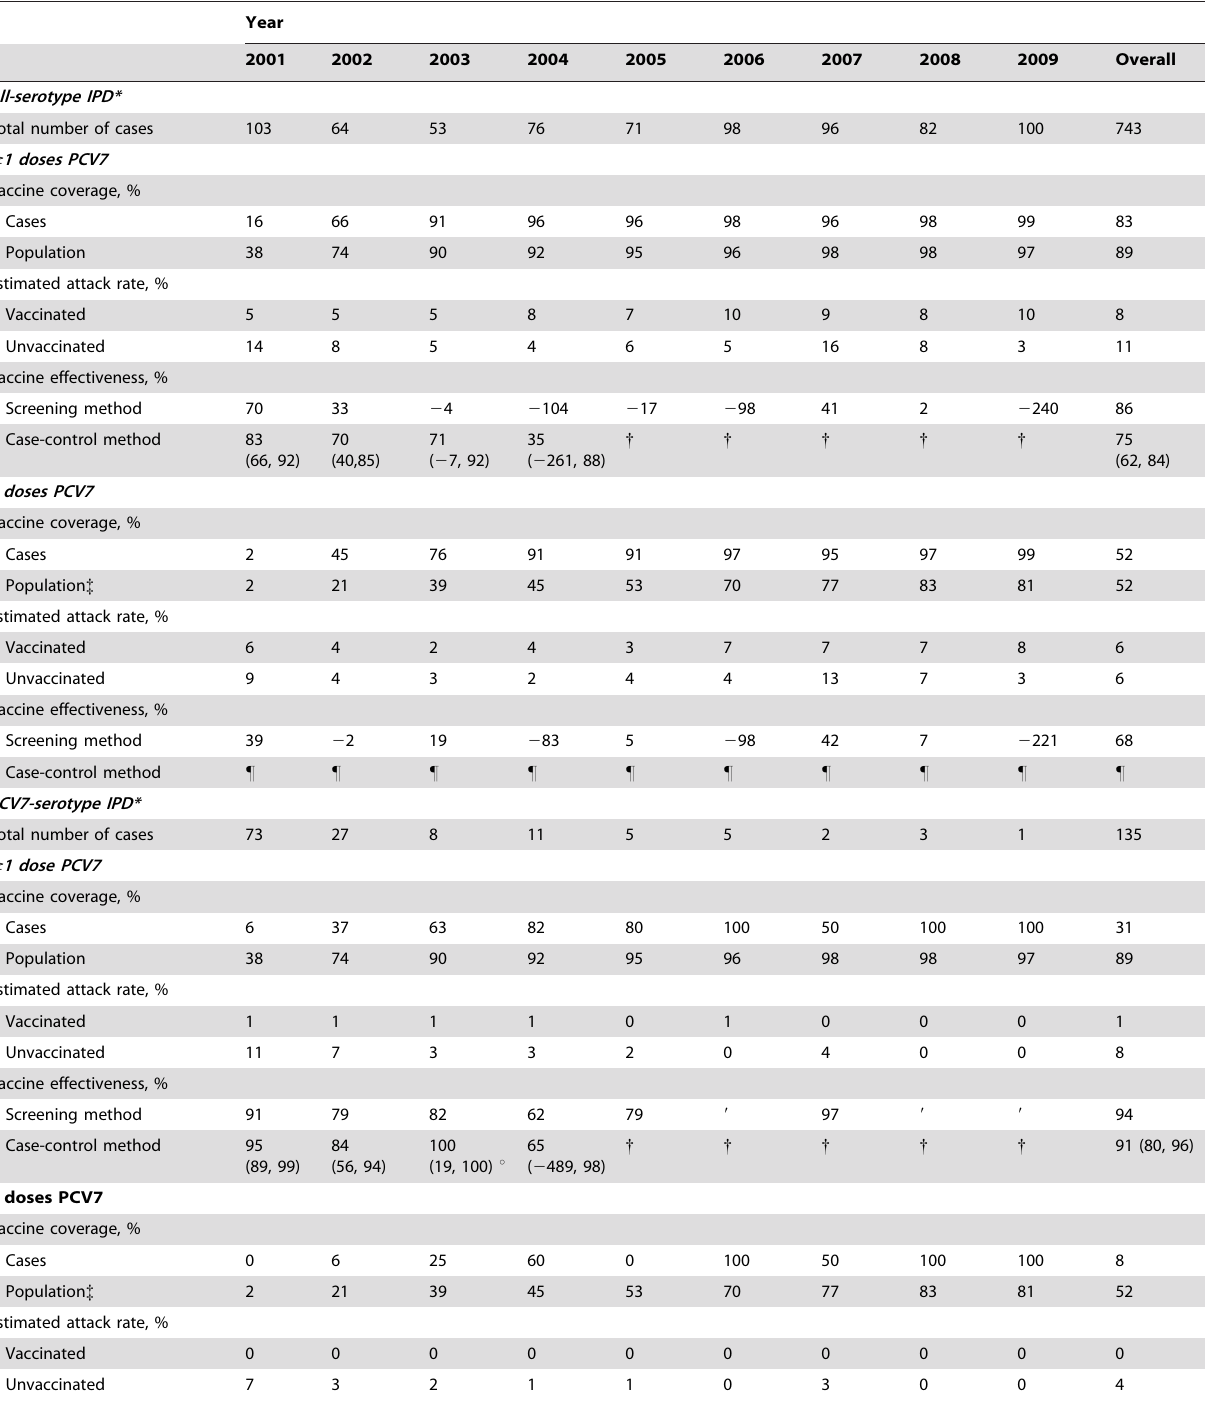
Table 1. Vaccine effectiveness of at least one dose and 4 or more doses of 7-valent pneumococcal conjugate vaccine (PCV7) against all-serotype invasive pneumococcal disease (IPD) and PCV7-serotype IPD among children 19–35 months of age with vaccine histories using unadjusted screening and case-control